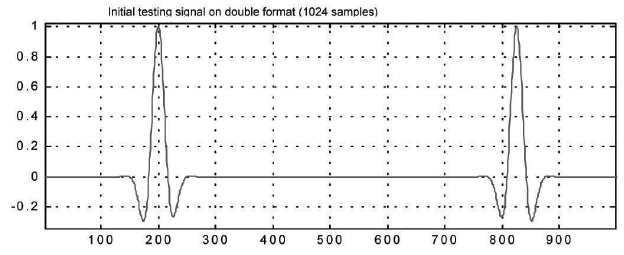
Figure 5. Test signal - modulated Gauss pulse (3.1) on double time